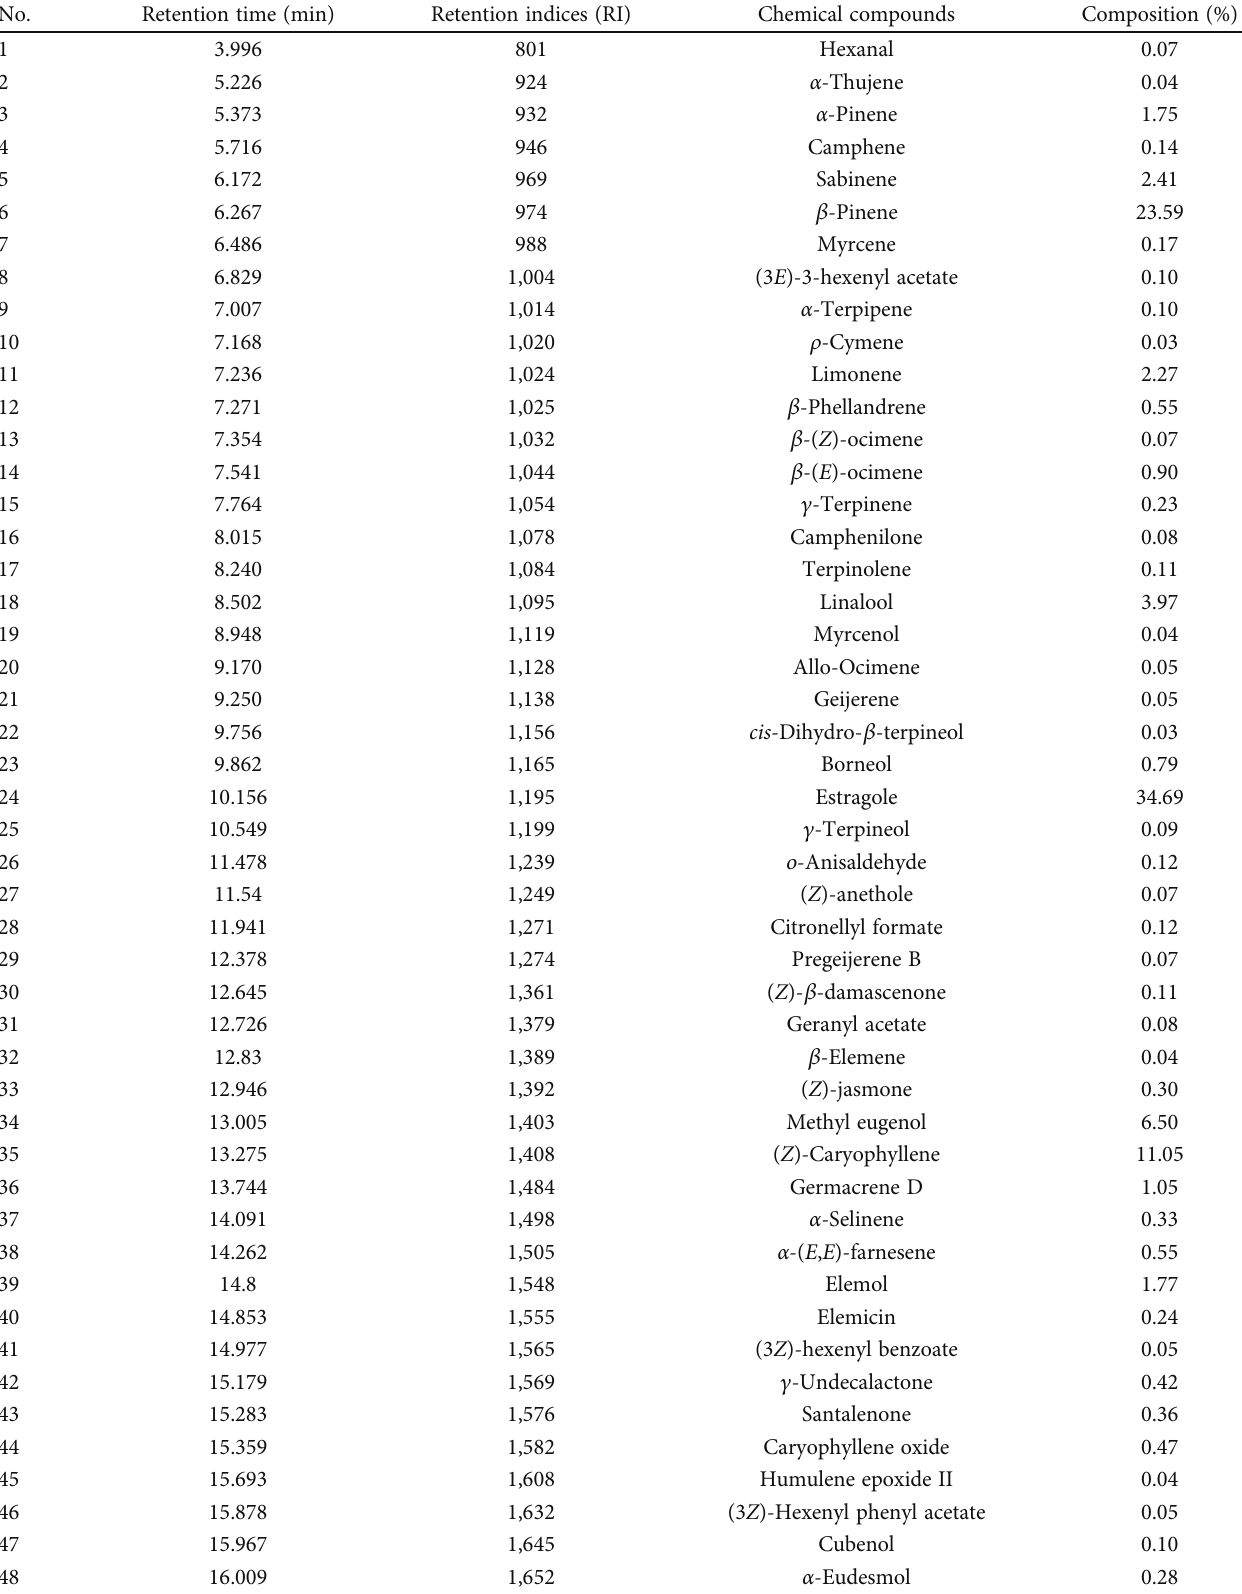
Table 1: Chemical compounds of the essential oil of F. limonia